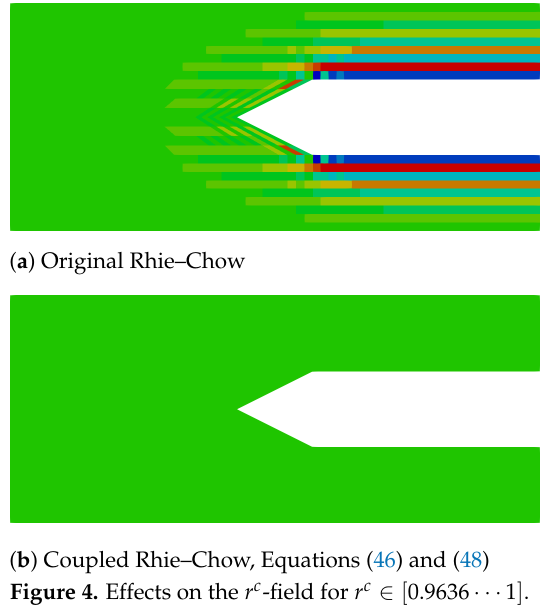
Figure 4. Effects on the r c -field for r c